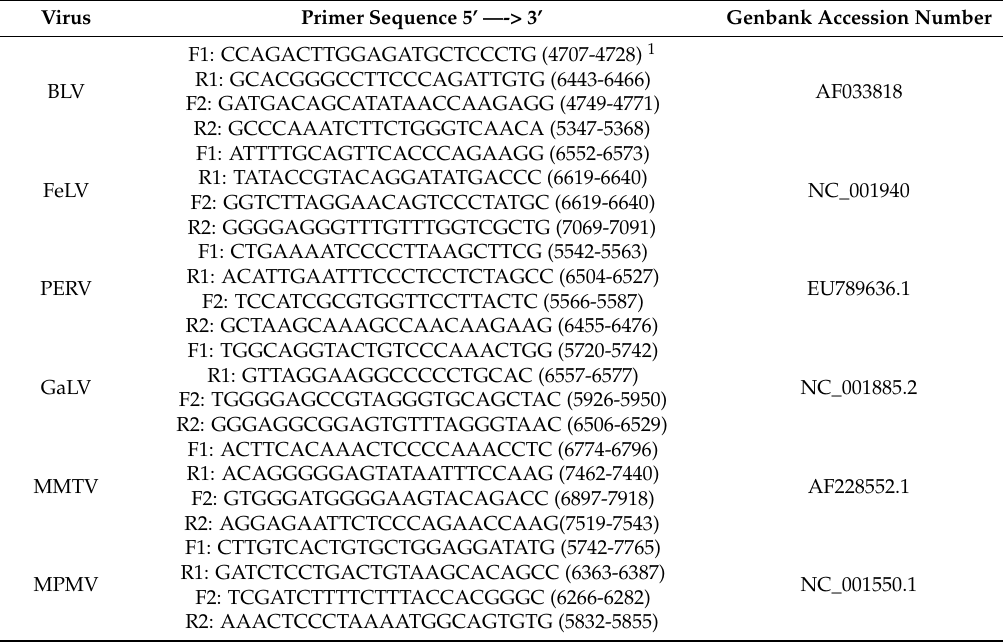
Table 1. PCR primer sets used to amplify env -specific sequences from the indicated